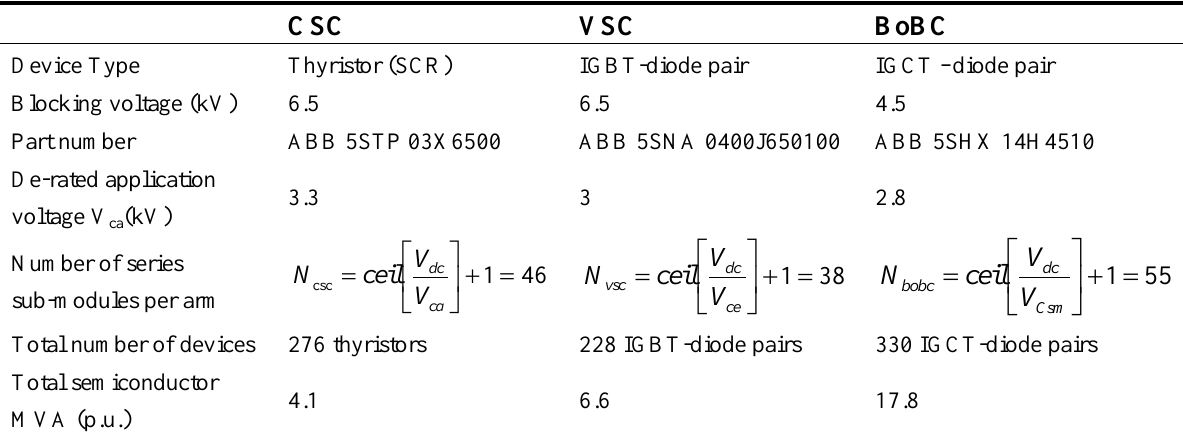
Table 3. Summary of semiconductor selection and utilization data for converter